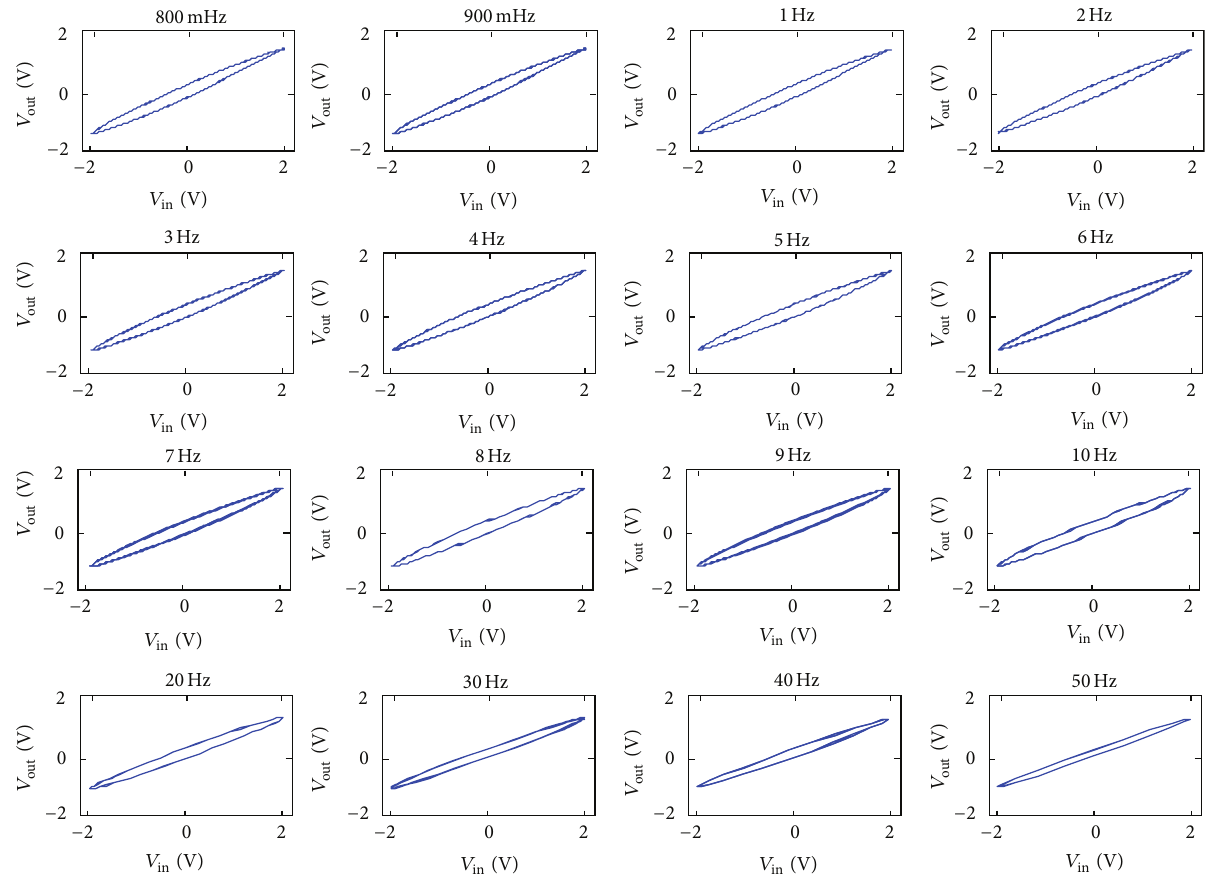
Figure 6: Lissajous curves on measured input ( V in ) and output ( V out ) voltages in the frequency range between 800 mHz and 50Hz for the device IPMC AbsT- 5 h